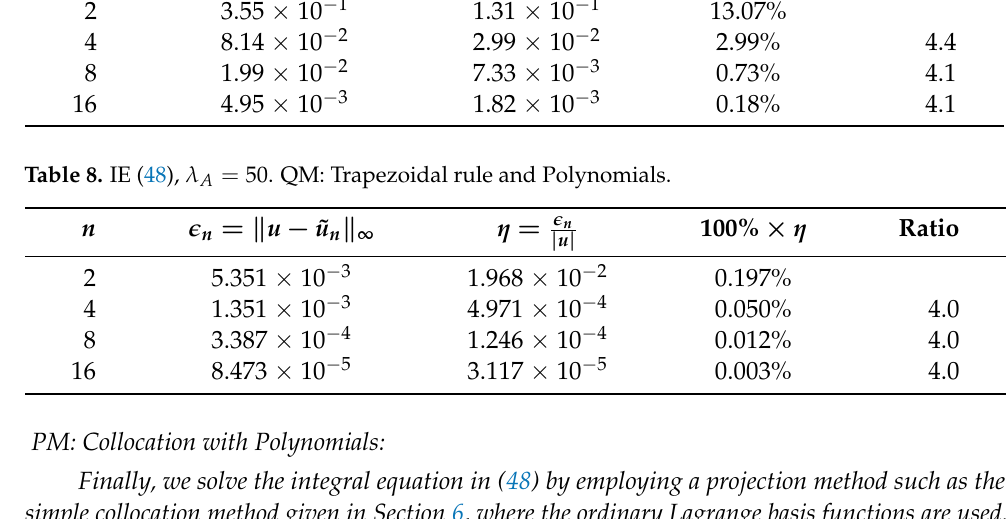
Table 7. IE (48), λ A = 2. QM: Trapezoidal rule and Polynomials. n